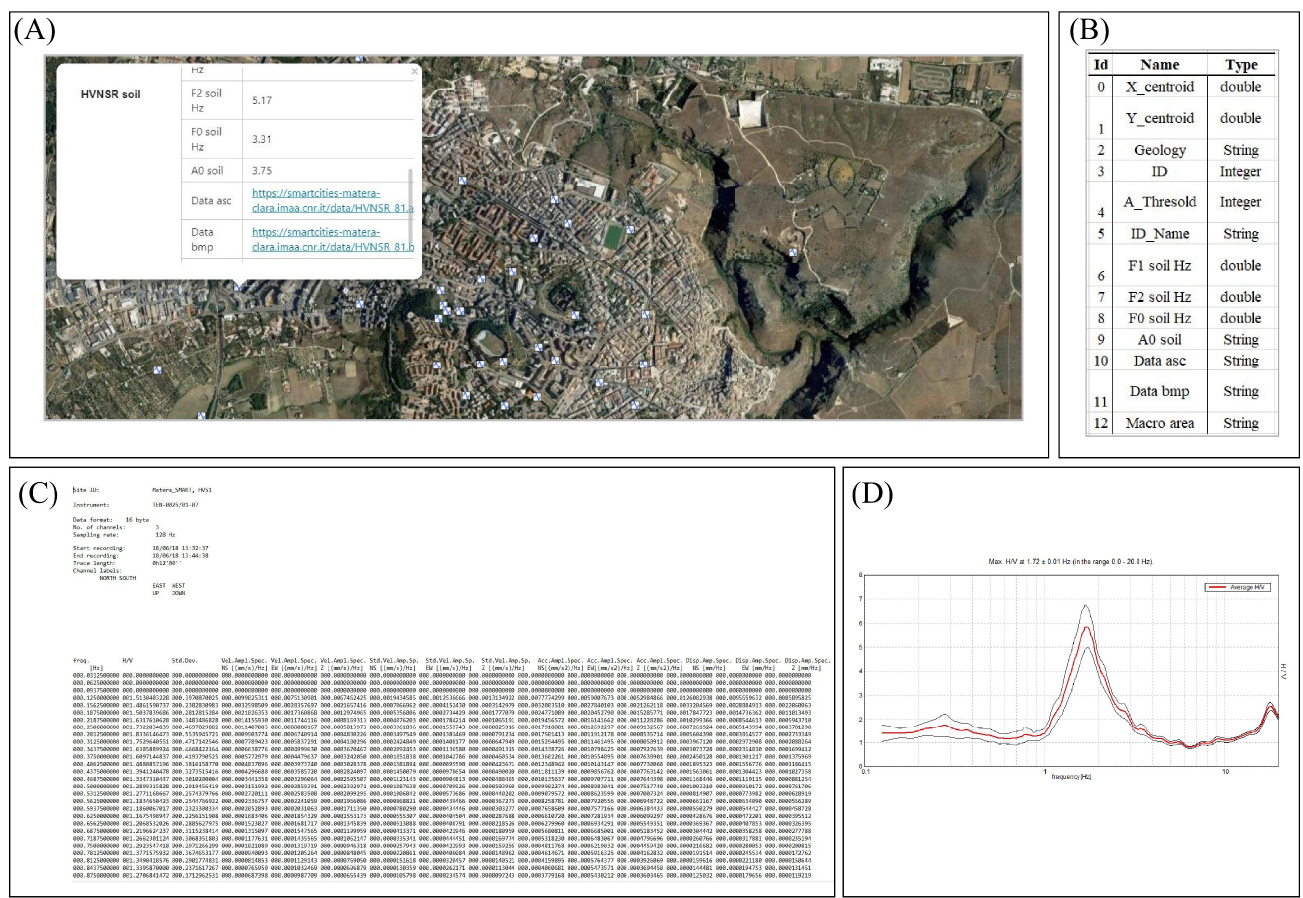
Figure 4. ( A ) Pop-up window showing the factsheet of a sample measurement (HVNSR_51) made on soil; ( B ) types of attribute; screenshots of downloadable ( C ) HVNSR text file and ( D ) HVNSR curve bmp file.